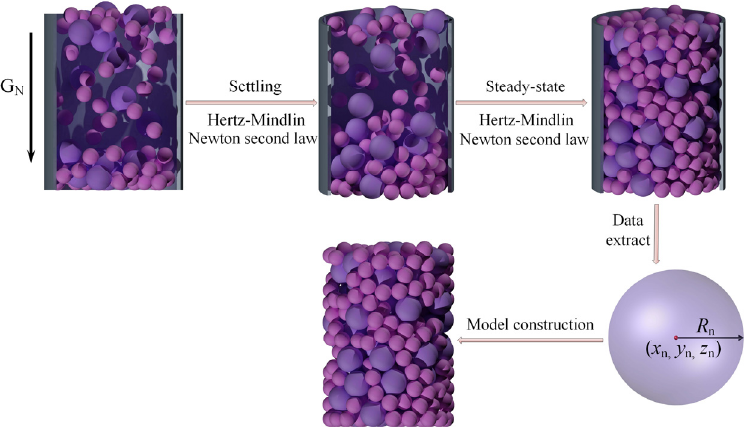
Figure 1. Simulation steps for the construction of the randomly packed bed using the DEM method.